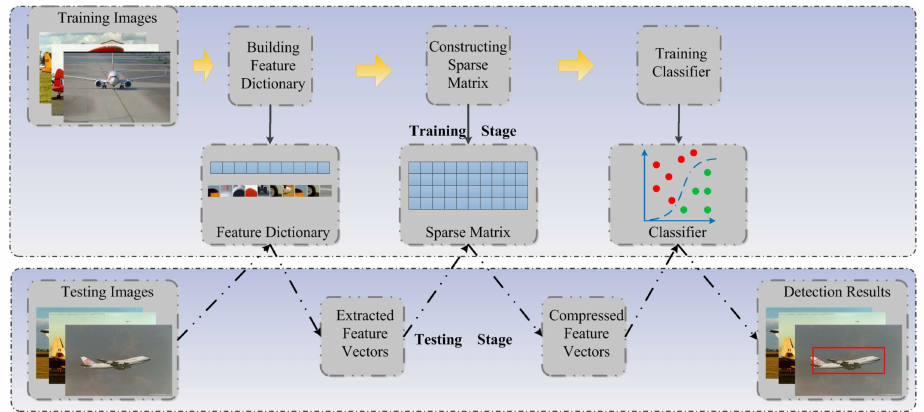
Figure 1. Framework of the proposed